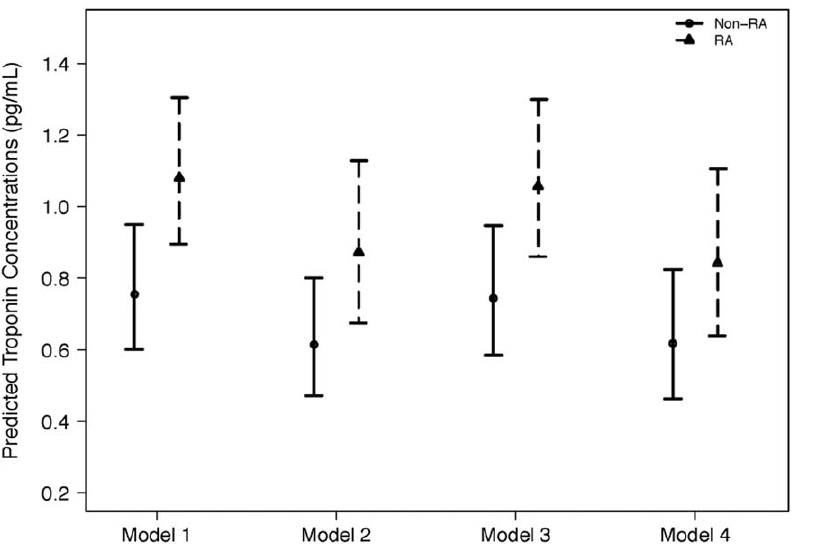
Figure 2. Multivariable Linear Regression Troponin Models for RA Patients vs Controls. Model 1: Adjusted for patient age, race, gender (p=0.002) ; Model 2: Adjusted for age, race, gender, and cardiovascular risk factors (p=0.004); Model 3: Adjusted for age, race, gender and markers of inflammation (p=0.008); Model 4: Adjusted for age, race, gender, cardiovascular risk factors, markers of inflammation, and NT-proBNP (p=0.03).